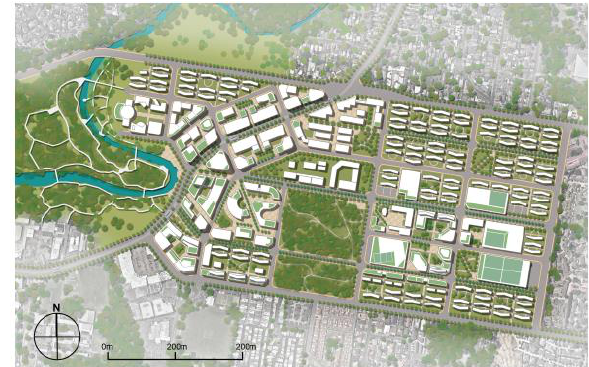
Figure 4: Scenario three vision for